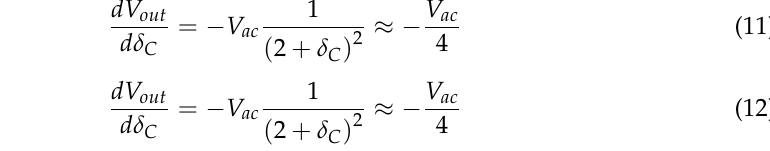
Figure 8. Traditional interfaces for capacitive sensors. ( a ) Capacitive voltage divider; ( b ) capacitive Wheatstone bridge. Here, 𝑉 𝑎𝑐 and 𝑉 𝑜𝑢𝑡 denote AC amplitude values.